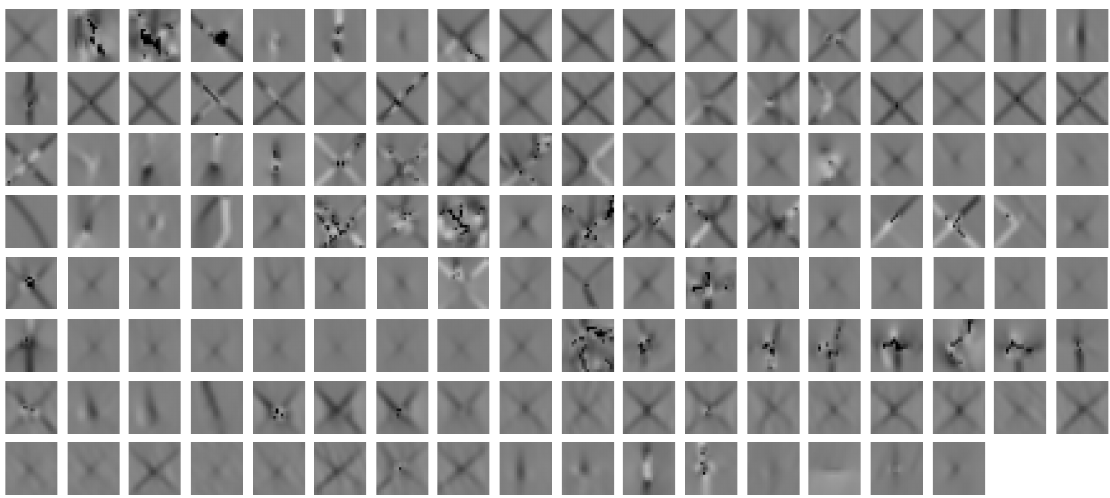
Figure 20. Image stacks correctly predicted as star cracks by SVM + conv3 (CNN 20) as an